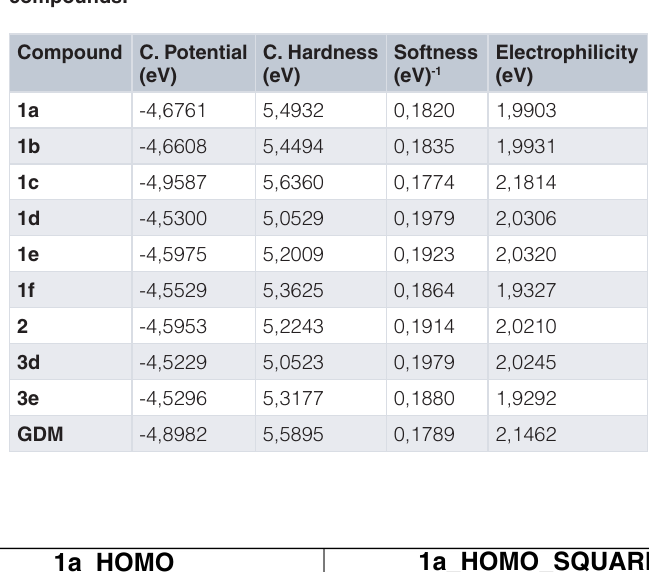
Table 7. Global reactivity descriptors to the most reactive compounds.